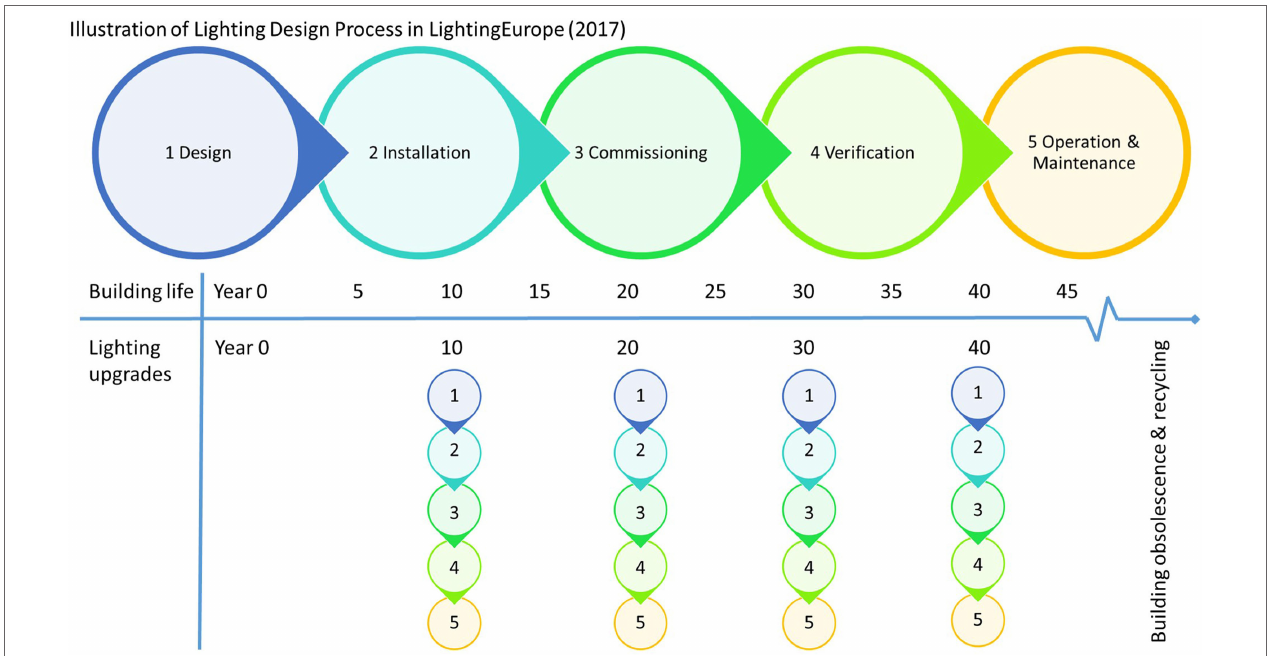
FigUre 1 | Illustration of the LightingEurope CEN/TC 169 “Lighting Design Process” alongside building